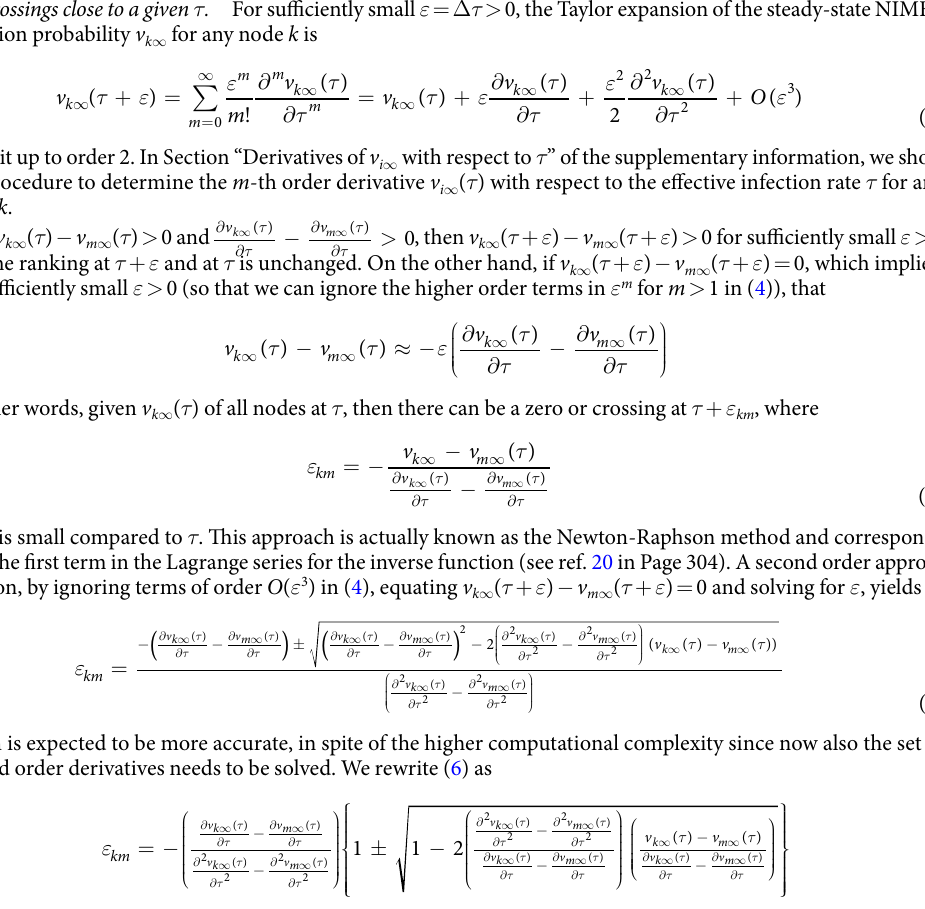
Figure 2. The lower bound χ l versus the total number of crossings χ τ ε τ + ( , ) the size N = 1000), BA random graphs (with the size N = 1000) and real-world networks (details in Section “Real-world graphs” of the supplementary